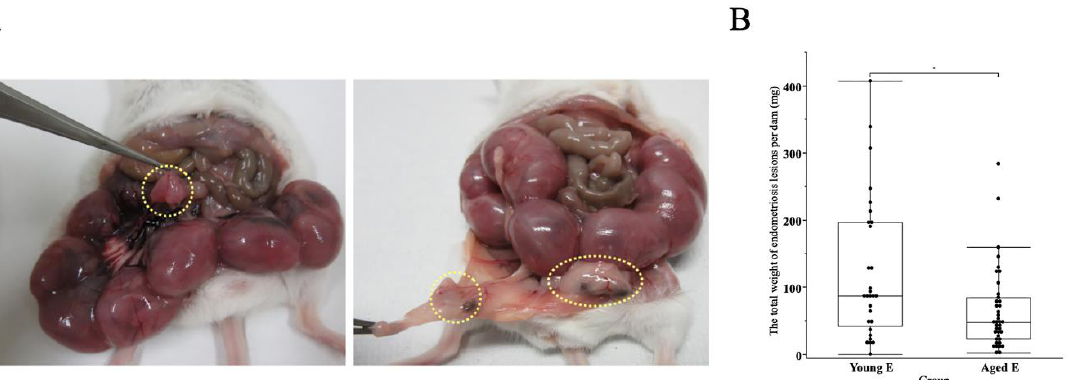
Figure 4. ( A ) Representative macroscopic images of anatomical relation of uterus and the endometriosis lesions (yellow dotted circles). The sacrifice was performed at 18 dpc. ( B ) A box-and-whisker graph of the total wight of endometriosis lesions per dam. The endometriosis lesions were weighted and analyzed using the Wilcoxon test. The total weight of endometriosis lesions per dam was significantly lower in Aged E group compared to Young E group ( p < 0.05). *: p < 0.05 (Young E; n = 29, Aged E; n = 39).